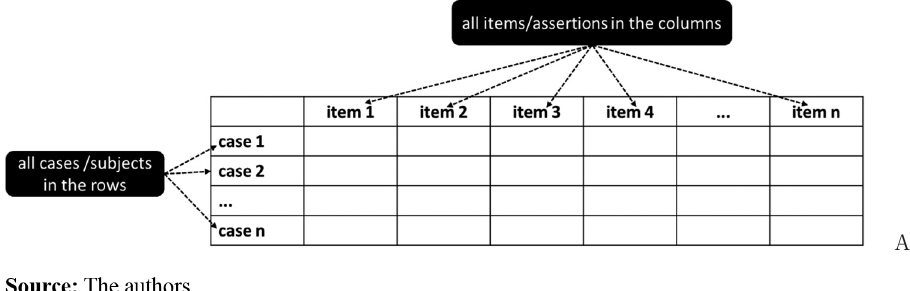
Figure 1. A suggested scheme for data